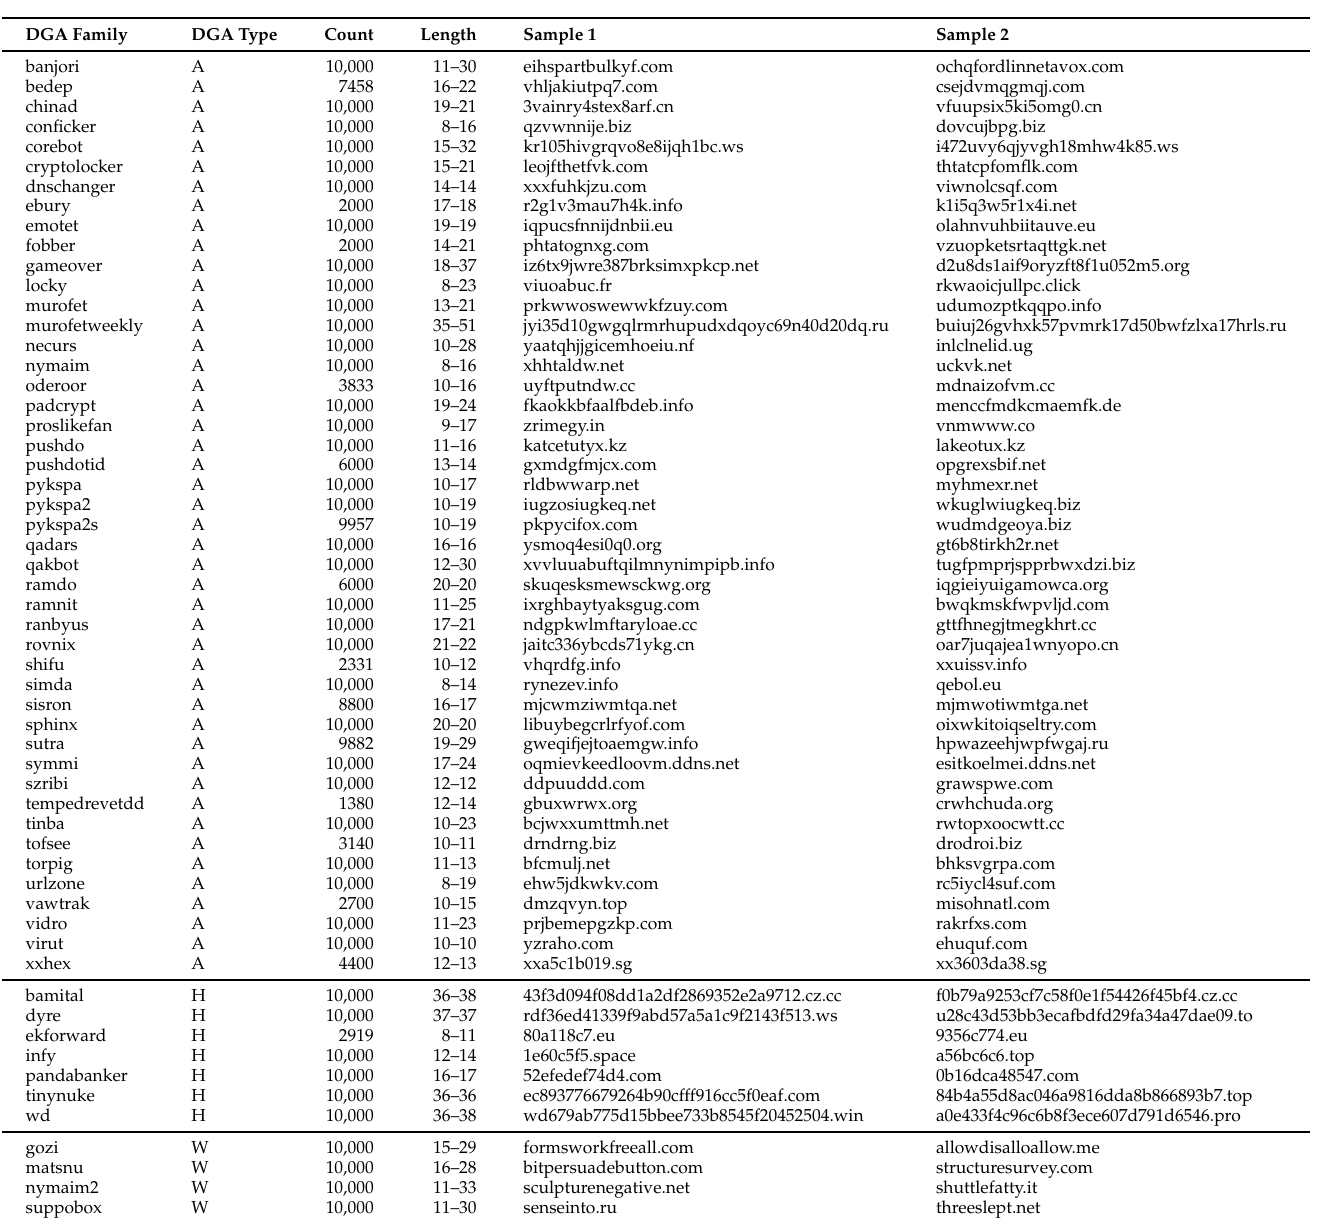
Table 5. Characteristics of DGA